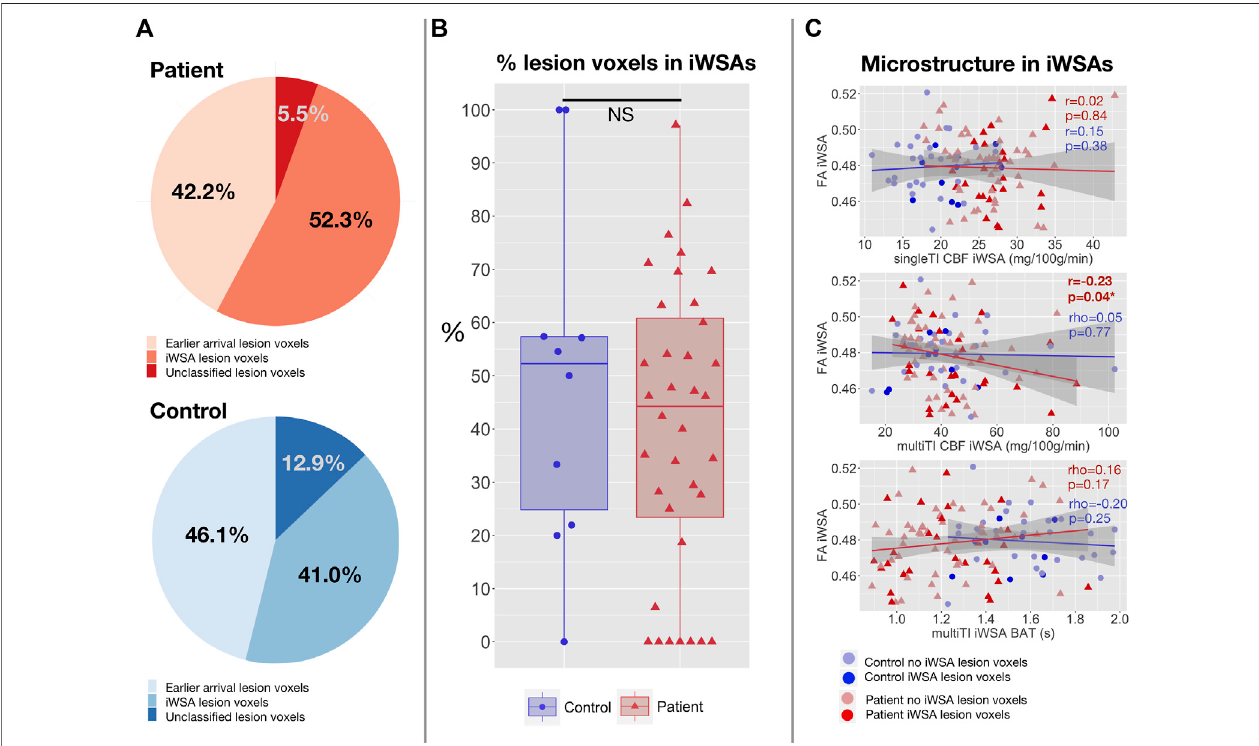
FIGURE 7 | Correlations with lesion burden and microstructural integrity in iWSAs. (A) Pie charts showing the proportion of total lesion voxels in white matter with earlyarrivaltimes,individualwatershedareas(iWSAs),andthatwereunclassi fi ed(i.e.,excludedduetounreliablesignalorerodedtoavoidpotentialpartialvolumeeffects) inpatientswithSCA(top;showninred)andcontrols(bottom;showninblue). (B) Boxplotcomparingthemedianproportionofclassi fi edlesionvoxelsinwhitematterwith late arrival times/iWSAs between SCA patients (shown in red) and controls (shown in blue). (C) Scatterplots showing the association between age-and sex- adjustedmedianfractionalanisotropy(FA)andage-andsex-meanadjustedcerebralblood fl ow(CBF)basedonthesinglein fl owtimesequence(top),CBFbasedonthe multi in fl ow time sequence (middle) and bolus arrival time (BAT) based on the multi in fl ow time sequence (bottom) across iWSAs in patients with SCA (shown in red) and controls (shown in blue). Values are Spearman ’ s correlation coef fi cients (rho) and p -values (p).